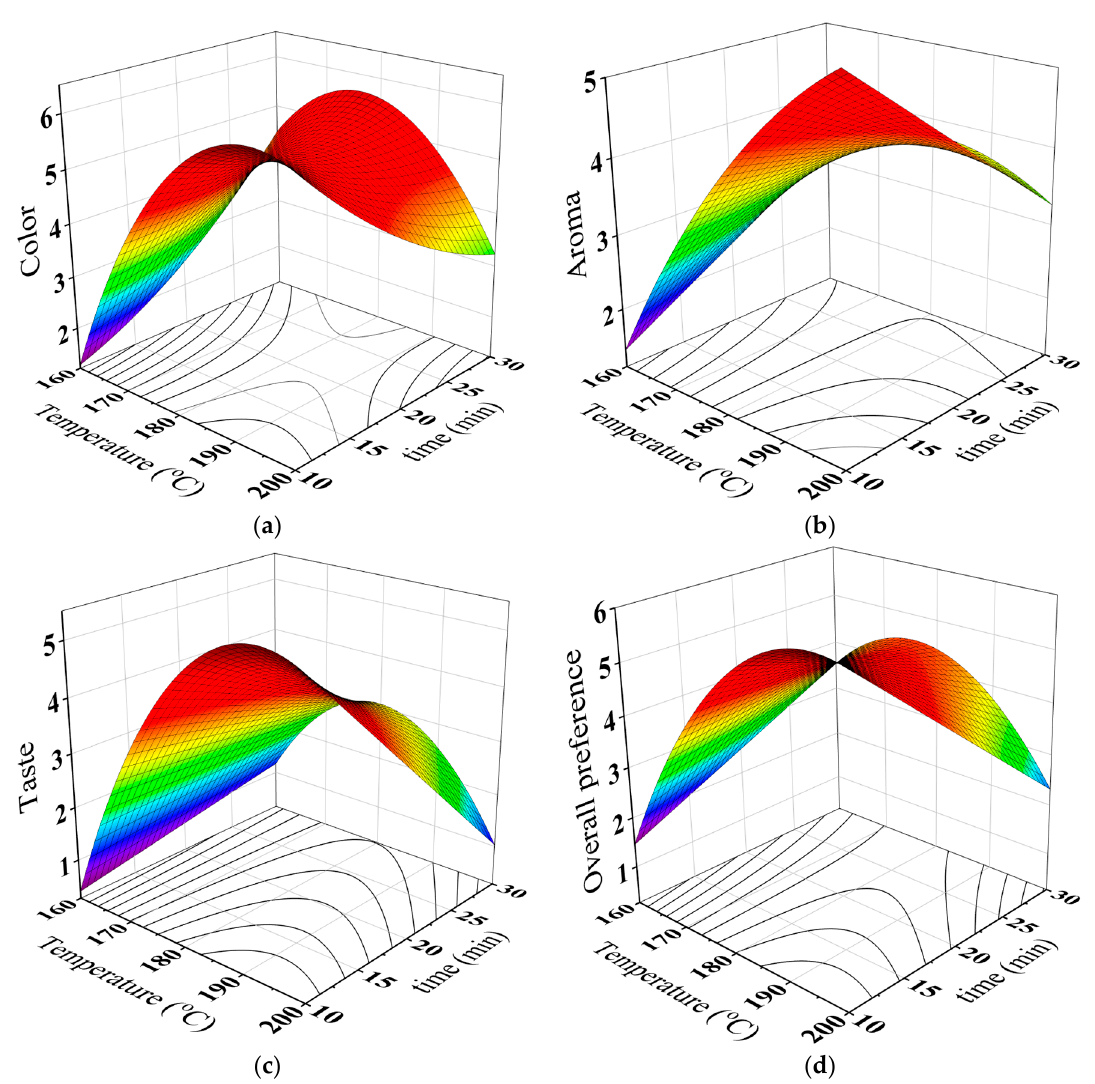
Figure 5. Surface responses and contour plots of color ( a ), aroma ( b ), taste ( c ) and overall preference ( d ) of the full-fat brew from palm date seeds as a function of roasting temperature and time.